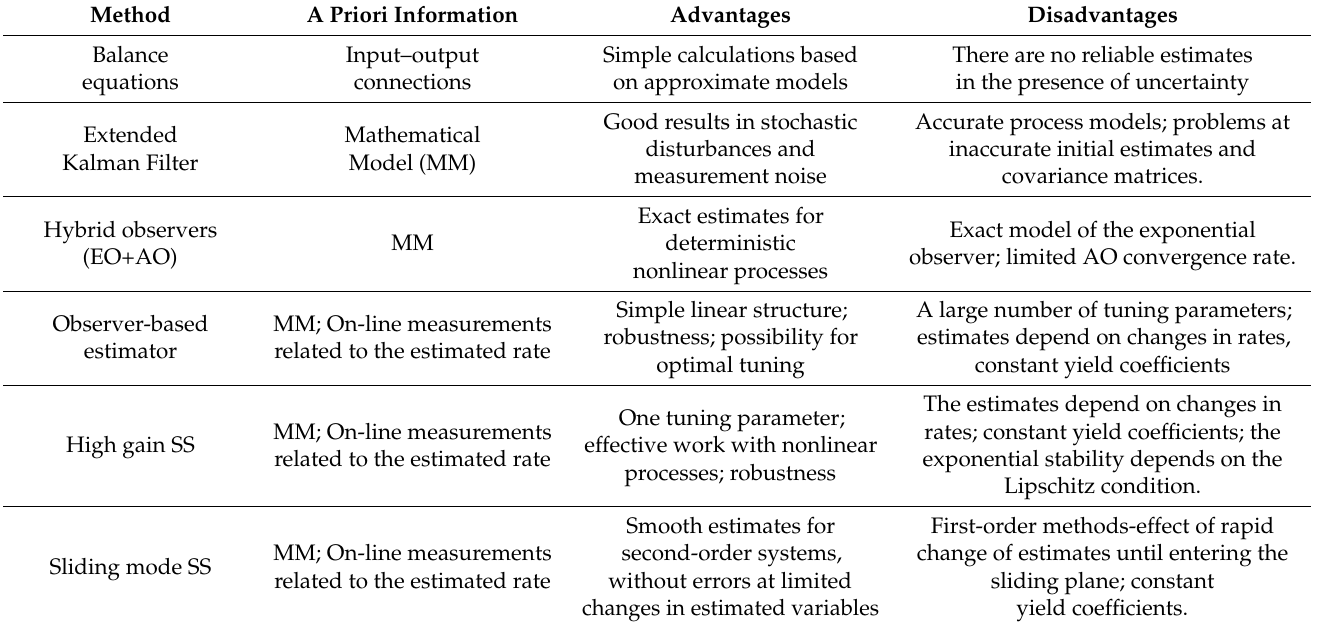
Table 3. Comparison of commonly used methods in BTP